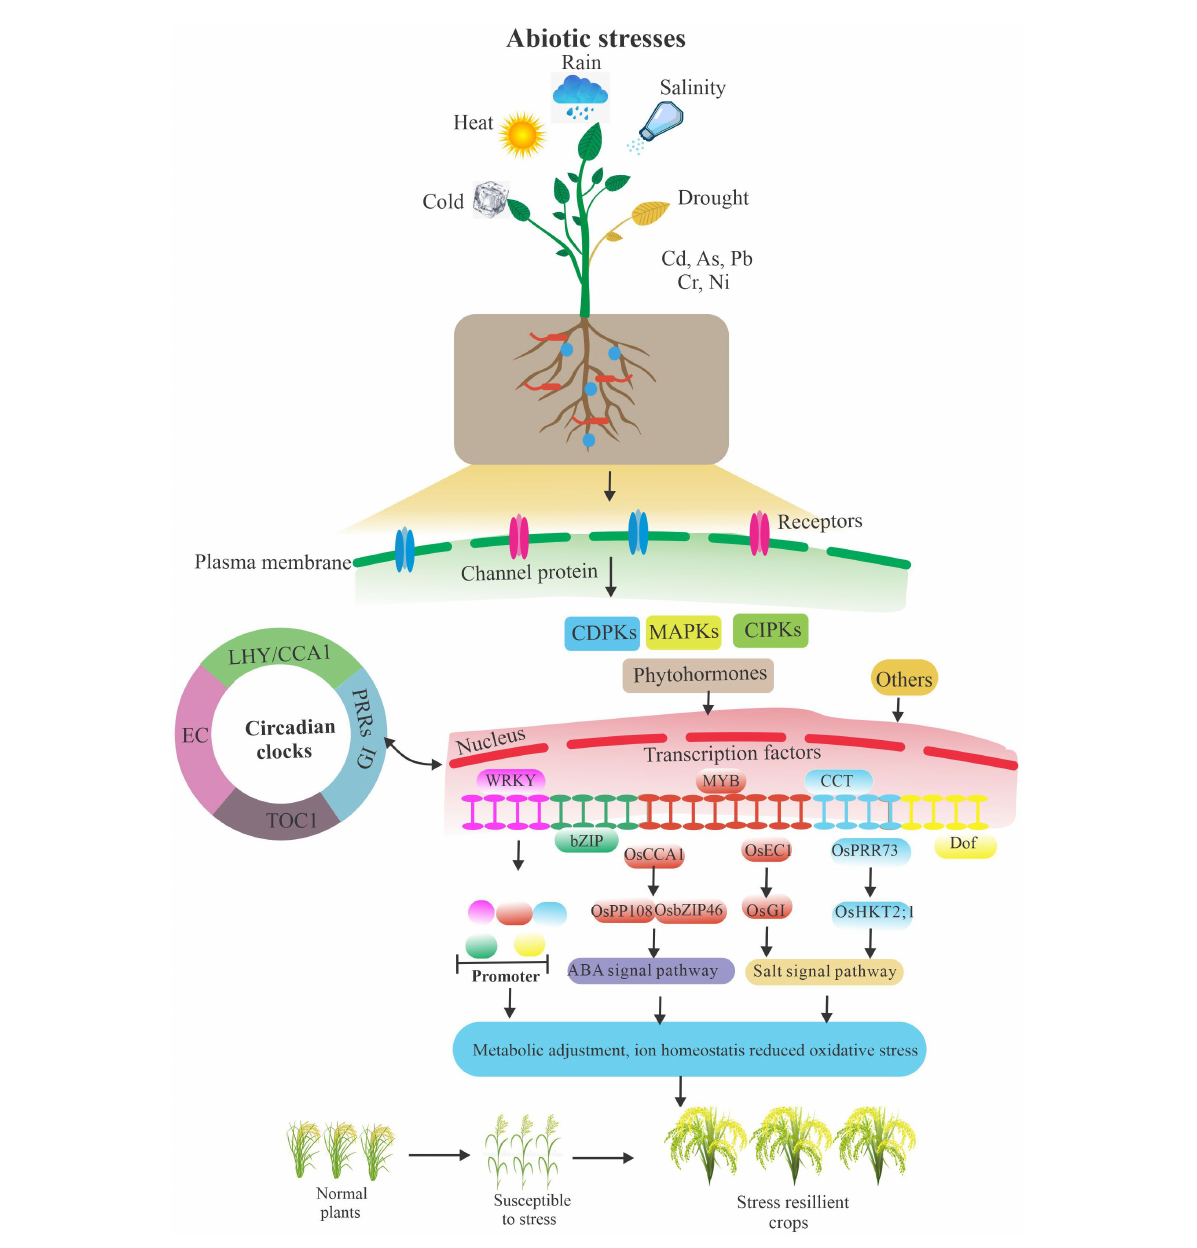
FIGURE 2 A simplified schematic of abiotic stresses and plant biology. Plants resist abiotic stresses by interacting with signaling pathways, circadian clocks, hormones, crucial genes transcriptional and post-transcriptional regulation, and other ways under environmental challenges. Others included endophytic fungi, a self-antioxidant defense system, proline accumulation, and so on. The arrows indicate the relationship between